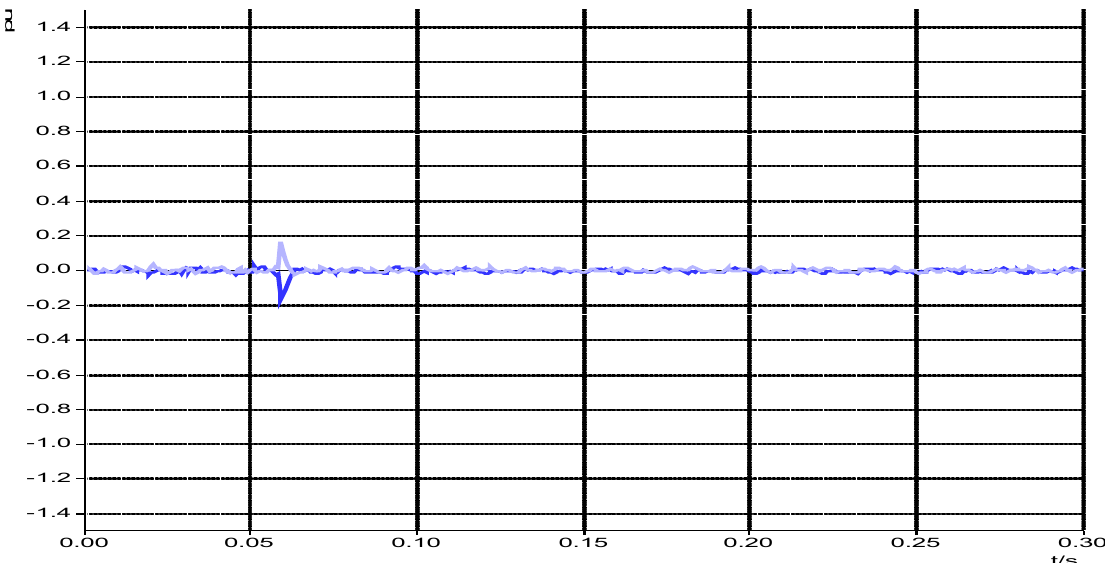
Figure 25. Voltages in a dq reference frame for a negative sequence (NEG).